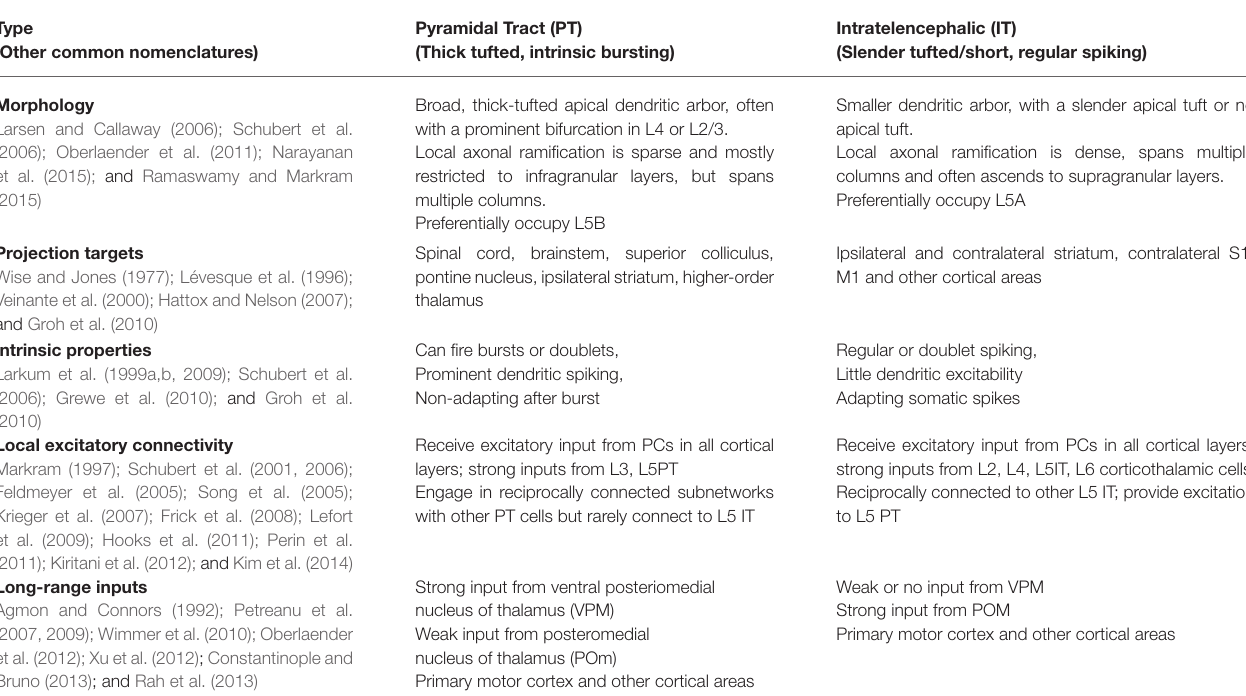
TABLE 1 | Properties and connectivity of layer 5 pyramidal neurons